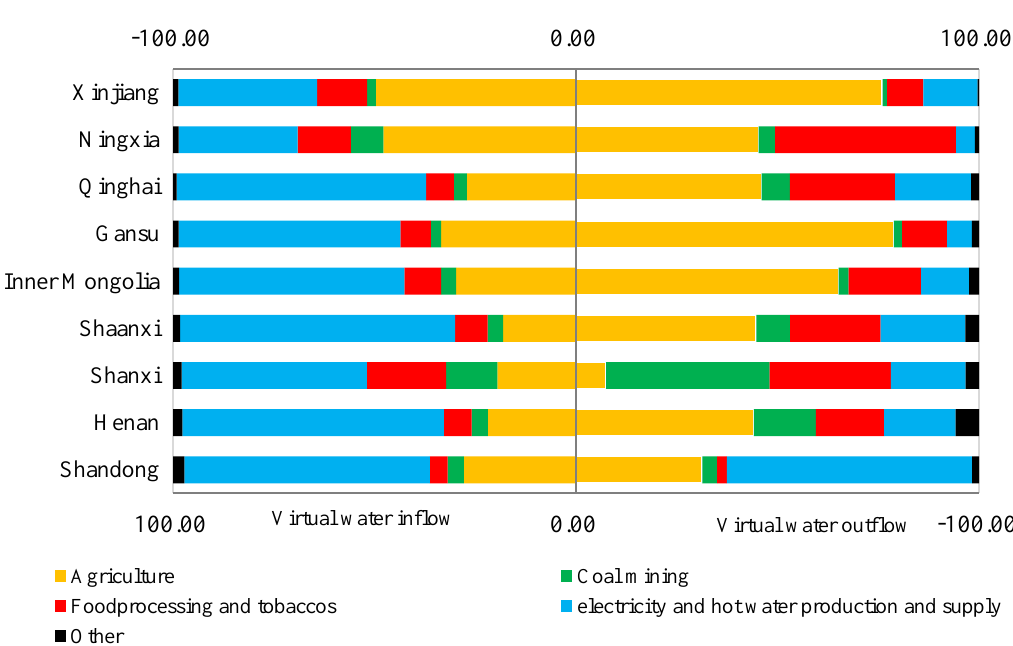
Figure 2. Virtual water trade pattern of sectors of in the Yellow River Economic Belt. (Source: Authors’ own calcula- tion/conception, based on MATLAB software).